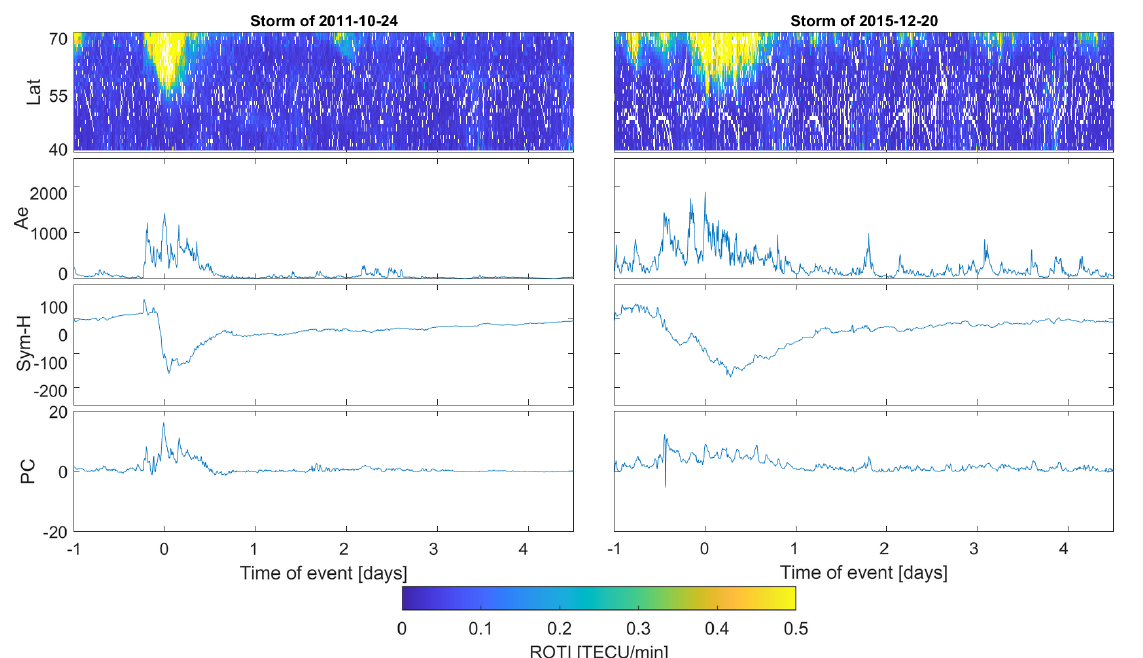
Figure 3. ROTI two − dimensional time series for strong geomagnetic storms (24 October 2011, and 12 December 2015) compared with Ae, Sym-H and PC indices